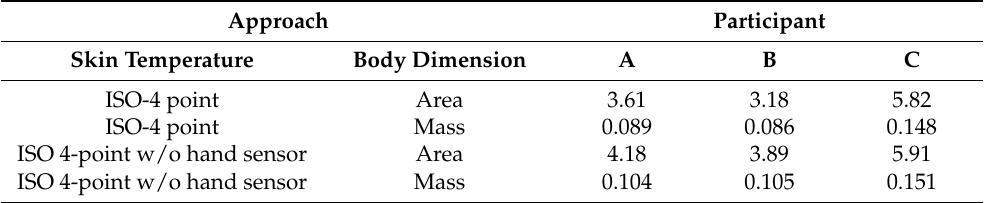
Table 7. Scaling constant relating skin temperature to the heating